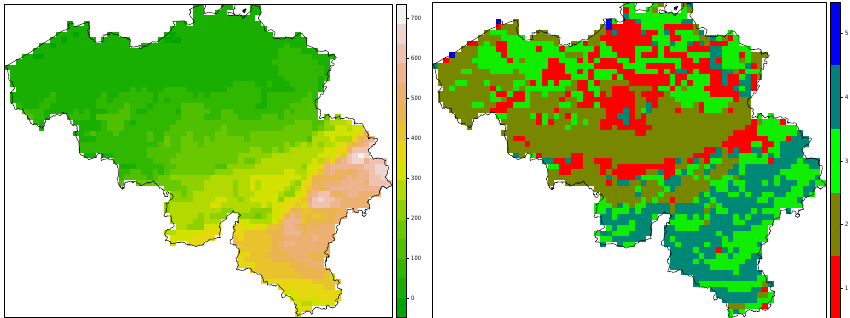
Figure 4. 4km resolution orography of Belgium [m] (left panel) and 4km resolution CORINE Land Cover in Belgium (right panel).